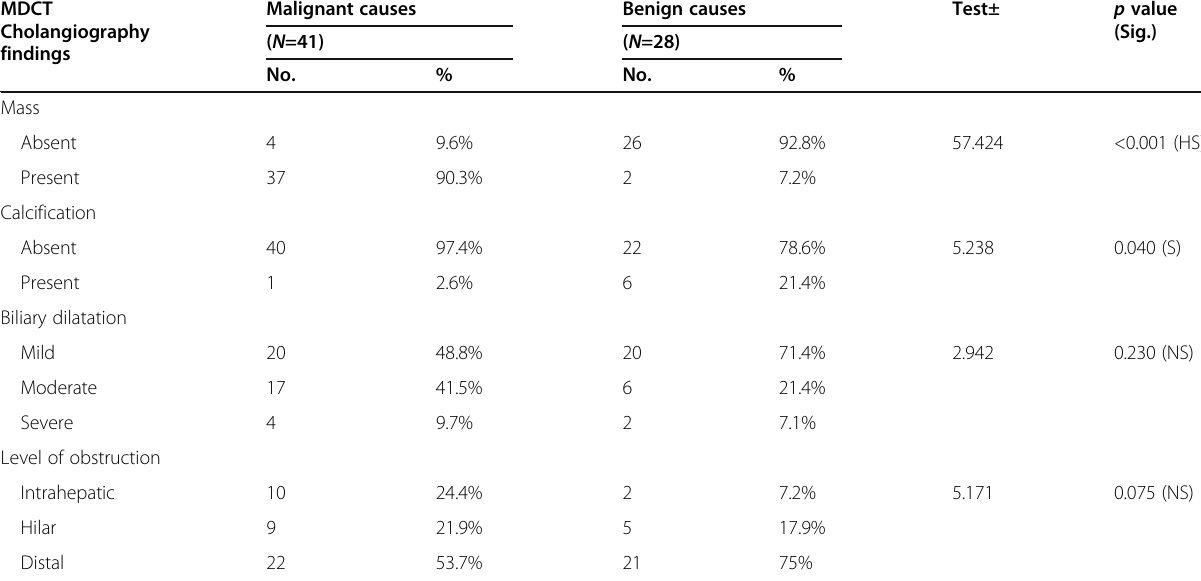
Table 3 Comparison between benign and malignant causes as regards MDCT cholangiography findings MDCT